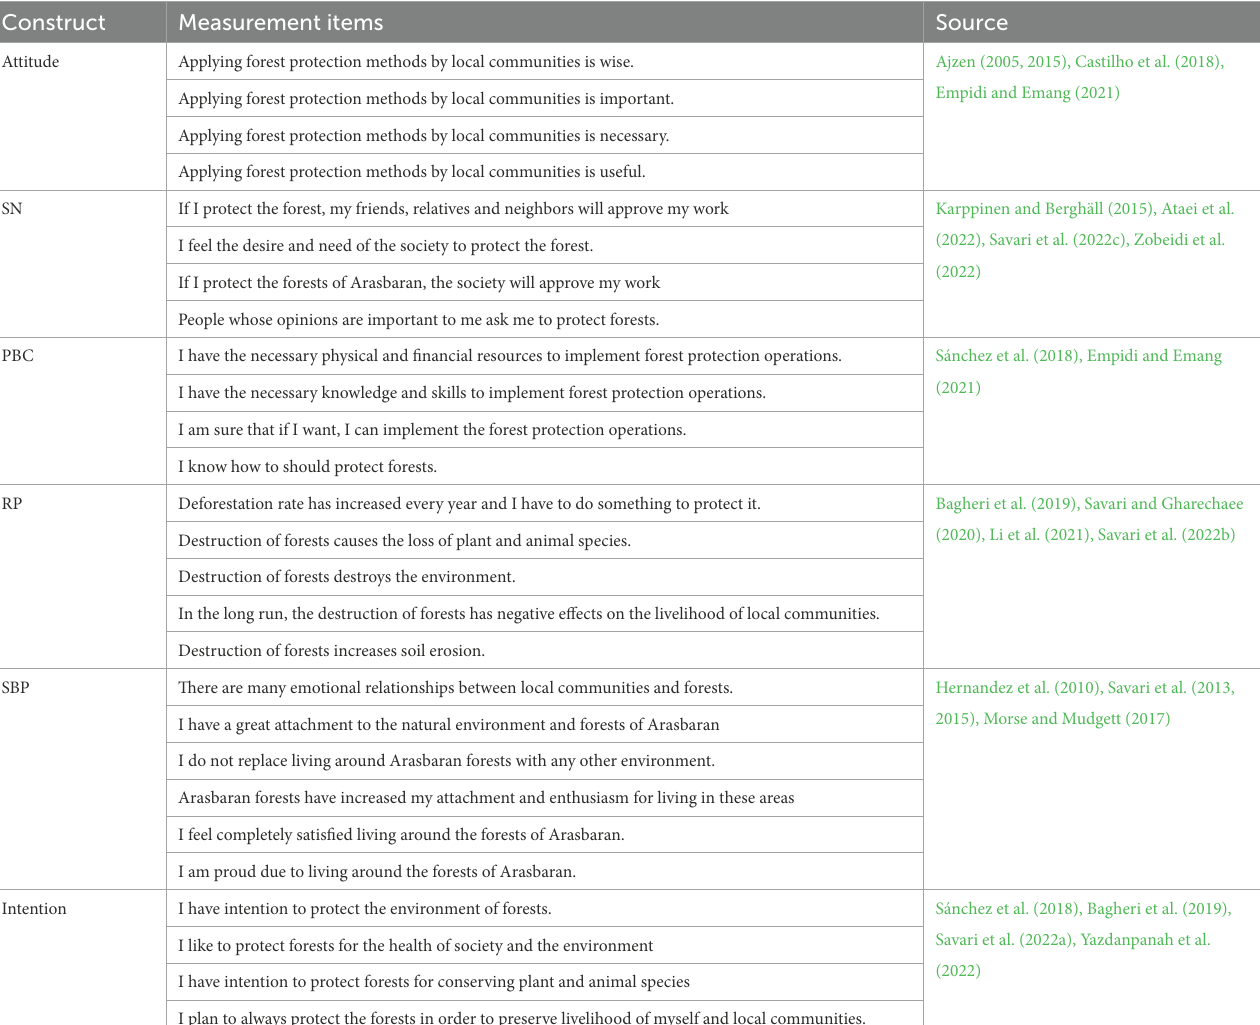
TABLE 1 Measurement variables of the